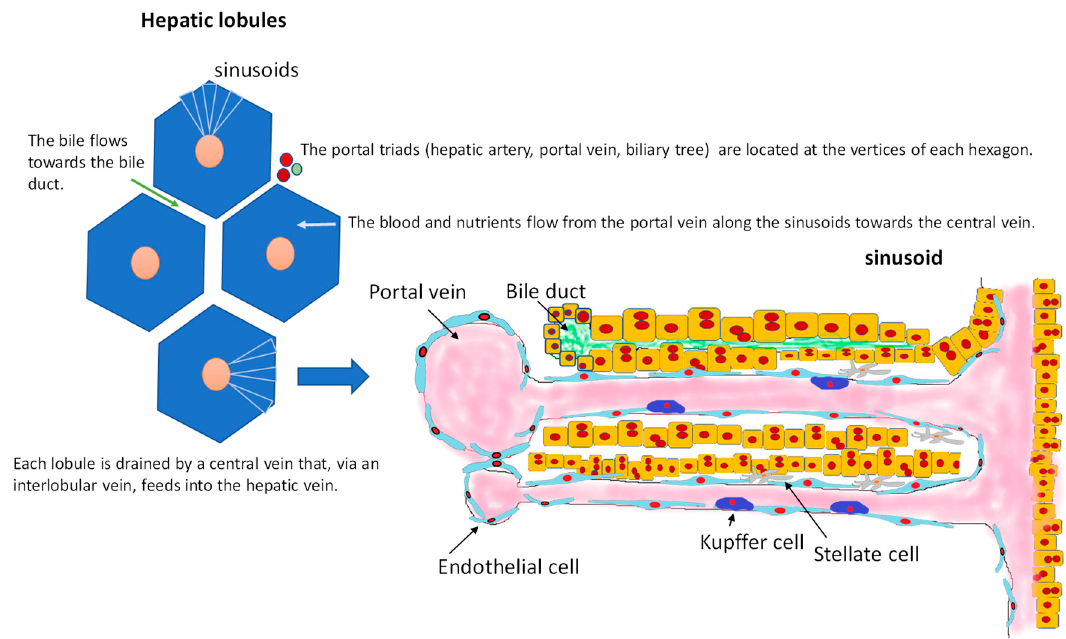
Figure 1. Structure of hepatic lobules. Oxygenated blood enters the lobules via a hepatic arteriole, and then flows through the sinusoids and drains into a central vein in the centrilobular region. Blood enriched in nutrients and antigens from the gastrointestinal system enters the lobules via the portal vein. This blood is filtered by Kupffer cells, which are phagocytic cells found within and below the fenestrated sinusoidal endothelium. Hepatic stellate cells (fat-storing cells that secrete matrix proteins) and antigen-presenting dendritic cells are present in the space of Disse, which separates hepatocytes (epithelial liver cells) from endothelial cells. Biliary canaliculi are located between the two cords of hepatocytes.